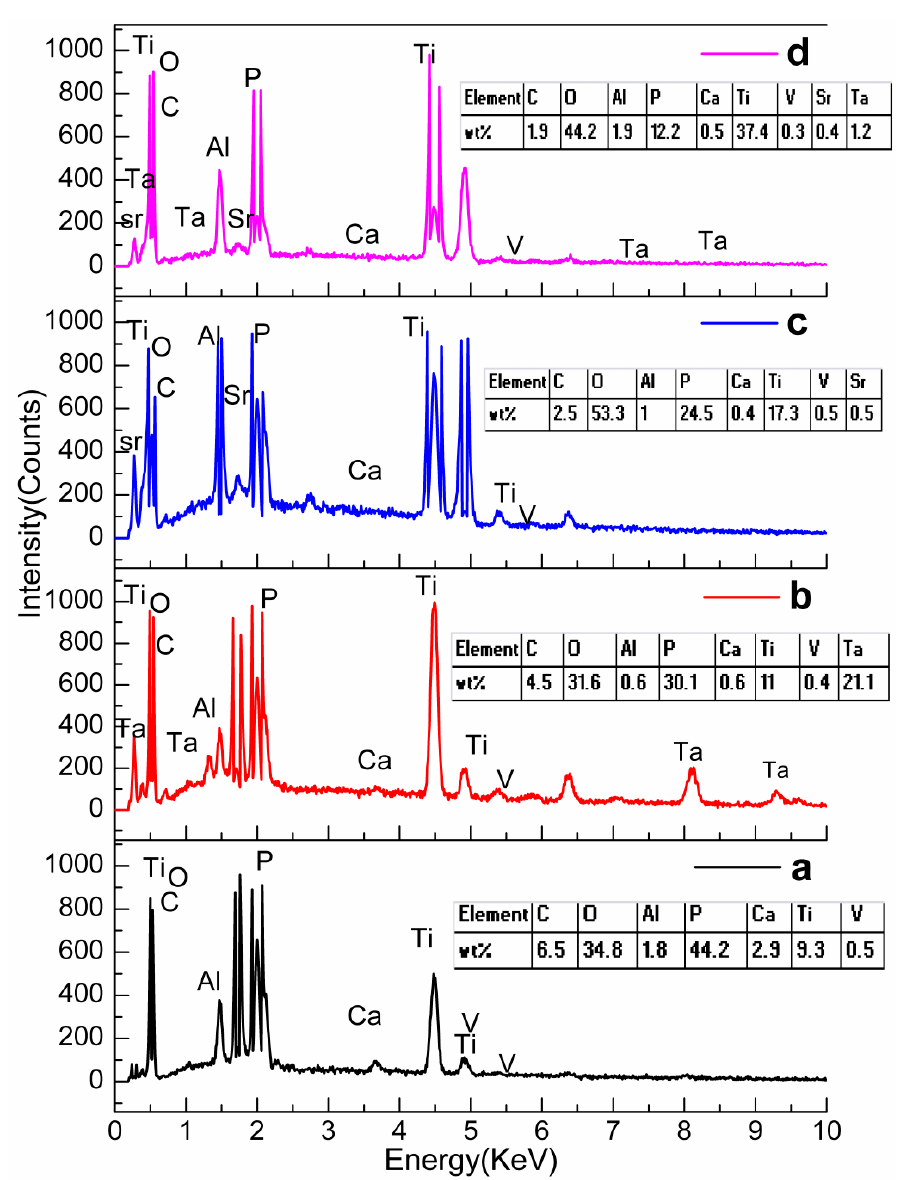
Figure 7. Energy dispersive spectra of ( a ) HA, ( b ) TaHA, ( c ) SrHA, and ( d ) SrTaHA.